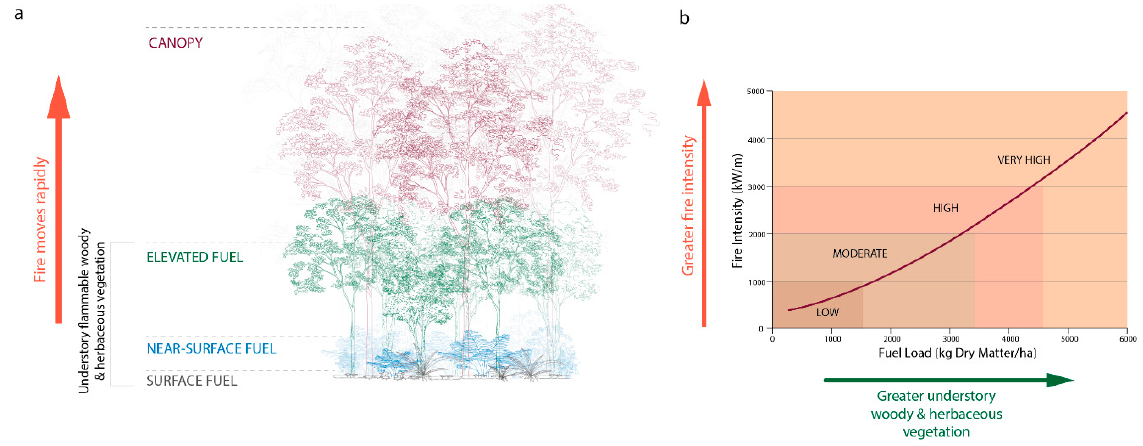
Figure 2. ( a ) Fuel layers that comprise the overall fuel load in Southeast Australian forests [33]: canopy (burgundy), elevated fuel (green), near-surface fuel (blue) and surface fuel (grey) each based on its position in the vegetation profile; ( b ) the relationship between fuel load and fire intensity in Eucalypt-dominant forest in Northern Australia [34]: fires at the landscape scale are modulated by: (1) the type and spatial array of fuels (i.e., vegetation); (2) climate via its influence over fuel condition (wet or dry); and (3) ignitions (humans and lightning). Fuel load (i.e., flammable vegetation) and moisture content tend to determine vegetation community flammability—the denser the fuel load (the x axis), the greater the fire intensity (the y axis).